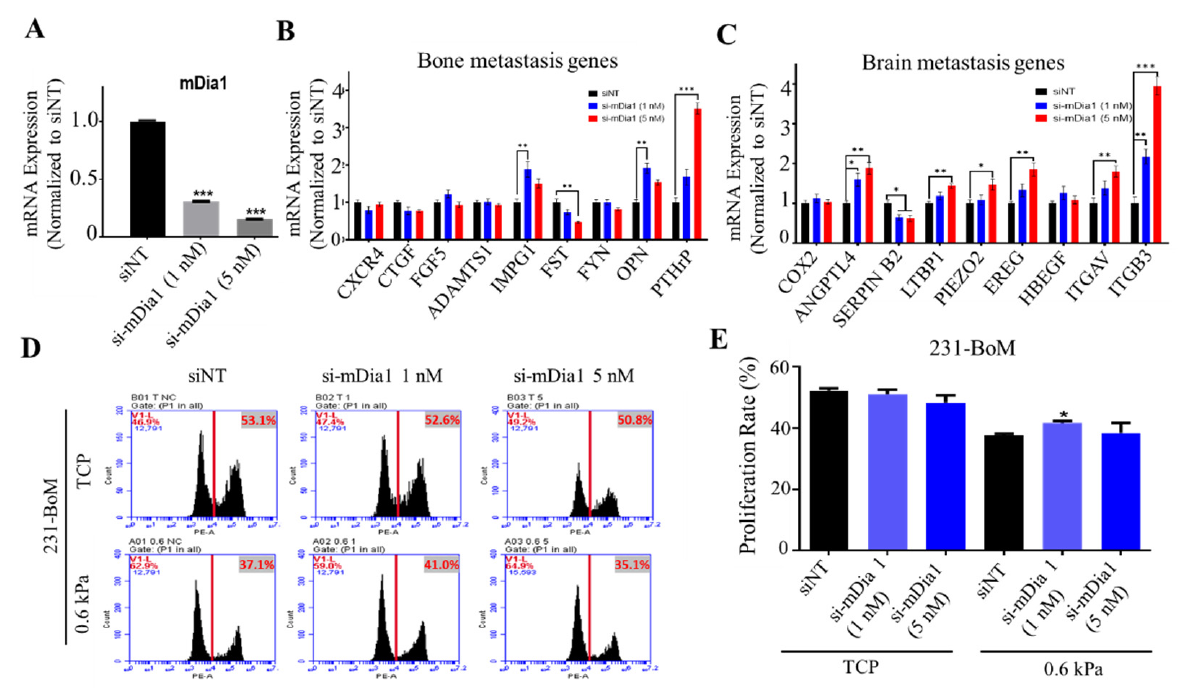
Figure 4. Silencing mDia1 in 231-BoM cells influences the expression profiles of the genes related to bone and brain metastasis and enhances cell proliferation on soft substrates. ( A ) The knockdown efficiency of mDia1. n = 3. ( B ) The influence of silencing mDia1 on the expressions of bone metastasis-related genes. n = 3. ( C ) The influence of silencing mDia1 on the expressions of brain metastasis-related genes. n=3. In addition, 231-BoM cells were transfected with mDia1 siRNAs, and the gene expression was examined in ( B , C ) by quantitative RT-PCR. ( D , E ) Silencing mDia1 promotes cell proliferation on soft but not stiff substrates. In addition, 231-BoM cells with mDia1 knockdown were cultured on TCP and 0.6 kPa substrates and cell proliferation was measured by EdU assay. n=3. The data represent mean ± SEM. * p < 0.05; ** p < 0.01; and *** p < 0.001.